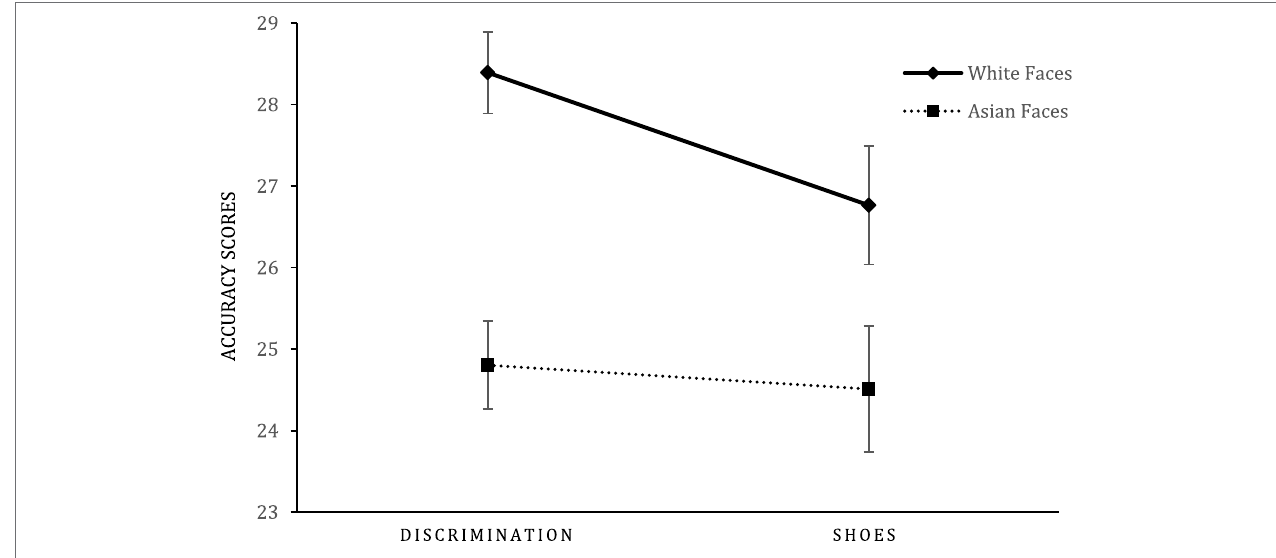
FIGURE 1 | Mean emotion recognition accuracy scores of priming conditions by target